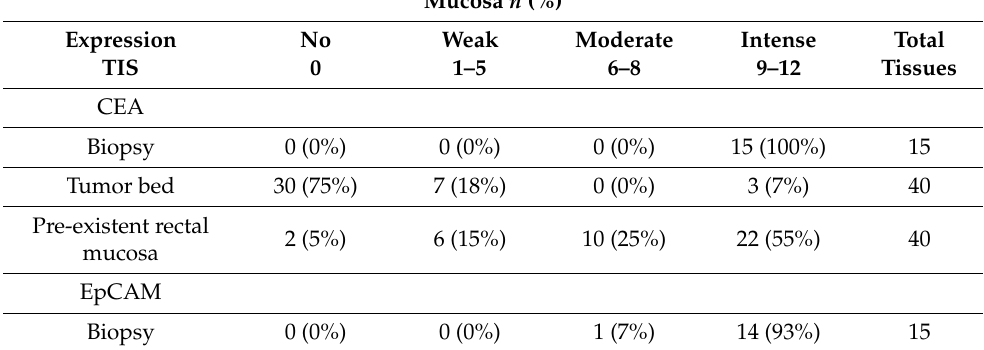
Figure 2. Representative images of CEA, EpCAM, α v β 6, and uPAR expression in a diagnostic biopsy and corresponding primary resection specimen derived from one patient with rectal cancer with a pCR after neoadjuvant therapy. ( A ) Diagnostic biopsy (magnification 5×, black bar = 200 μ m). ( B ) Corresponding primary resection specimen (magnification 1×, black bar = 1 mm). The arrow indicates the location of the tumor bed. The zoom contains a magnification of the transition area of tumor bed to adjacent pre-existent rectal mucosa (magnification 20×). Abbreviations: HE, hematoxylin–eosin; CEA, carcinoembryonic antigen; EpCAM, epithelial cell adhesion molecule; α v β 6, integrin α v β 6; uPAR, urokinase-type plasminogen activator receptor; pCR, pathological complete response. Table 2. Total immunostaining scores (TIS) of all stained tissues. Total Immunostaining Score (TIS) on Biopsy, pCR Tumor Bed, and Pre-Existent